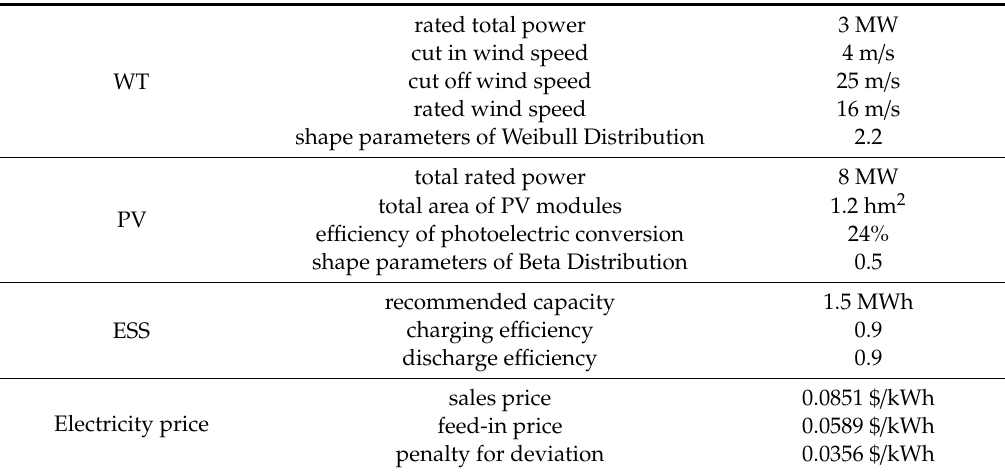
Table 3. Relevant